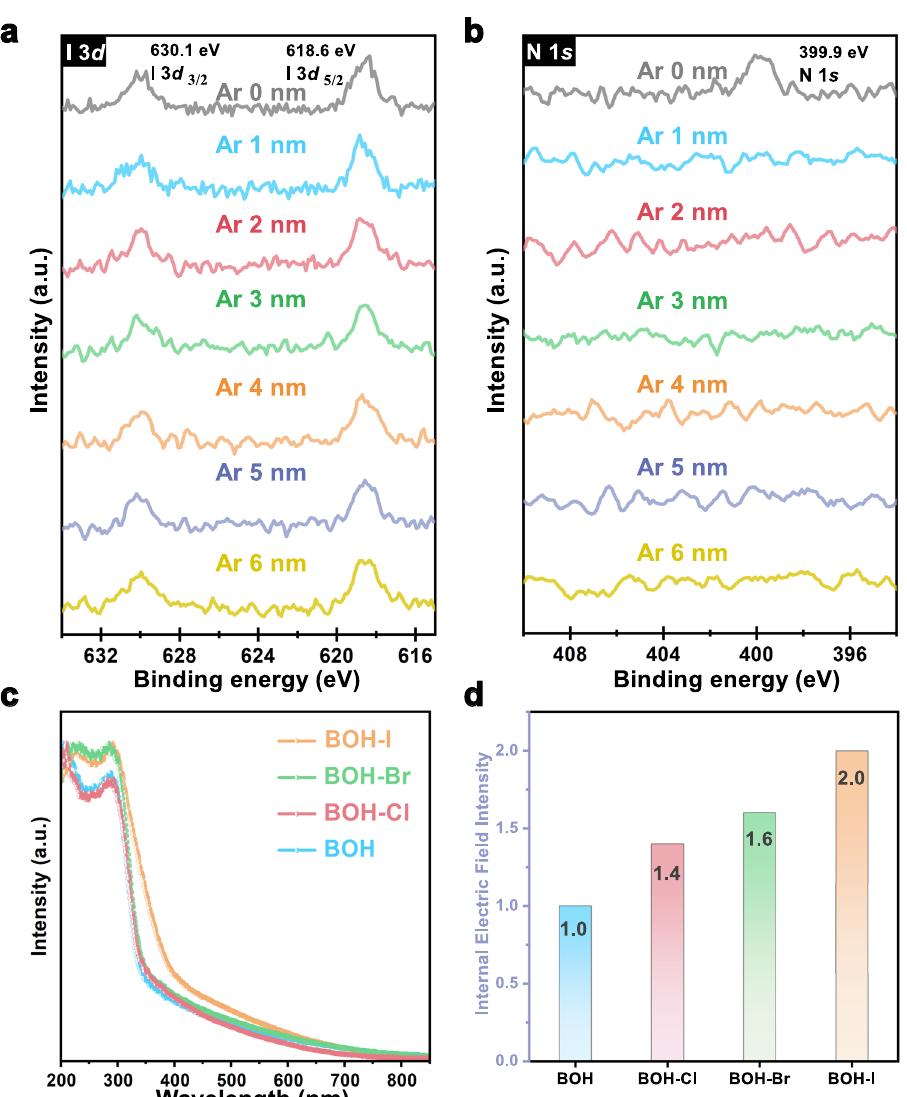
Fig. 4 Bulk structure, optical property, and internal electric fi eld analysis. High-resolution XPS spectra with Ar + sputtering at different depths of a I 3 d and b N 1 s for BOH-I. c UV – vis diffuse re fl ectance spectra for BOH and BOH-X. d Internal electric fi eld Intensity (assuming the intensity of BOH to be “ 1 ” ) for BOH and